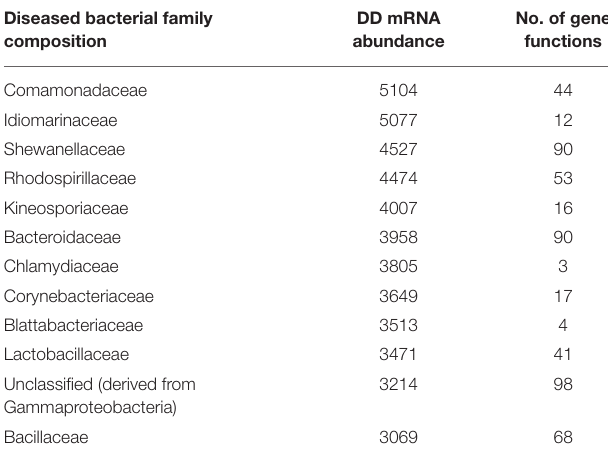
TABLE 2 | Bacterial community and family composition of Orbicella faveolata